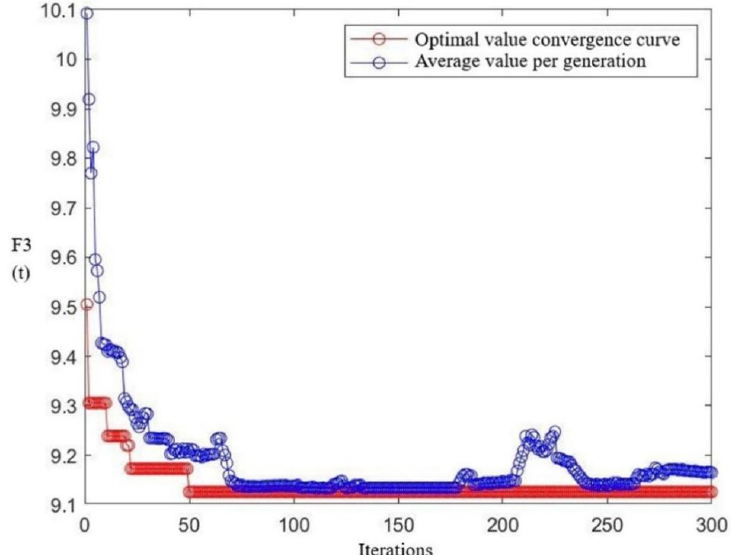
Figure 9. Optimal value convergence curve of fuel consumption and average value curve of each generation.